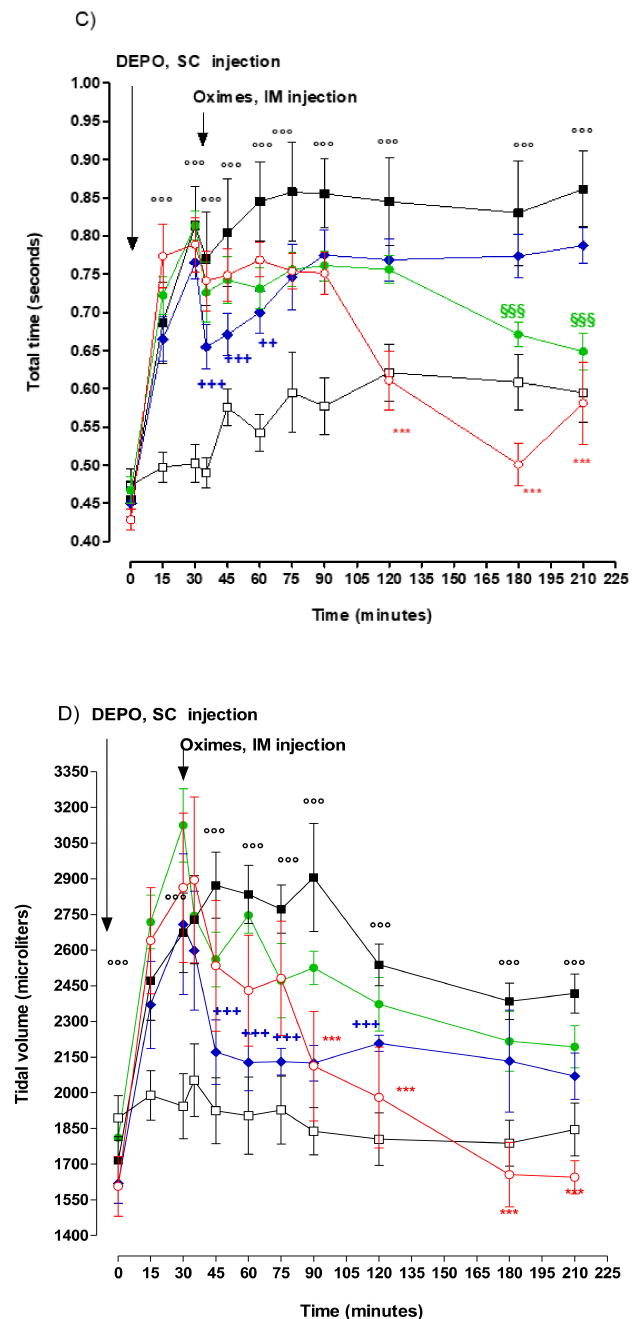
Figure 3. Time-course of frequency (f , Panel A ), expiratory time ( T E , Panel B ), total time ( T TOT, Panel C ), and tidal volume ( V T , Panel D ) in control group (open squares-black line), diethyl-paraoxon (DEPO) group (black squares-black line), diethyl-paraoxon + pralidoxime (DEPO + PRX group (blue diamond-blue line), DEPO + KO-27 group (green diamond-green line), and DEPO + BI-6 group (red open circle-red line). Each group contained eight rats. Data are represented by mean ± SEM. DEPO vs Control: ◦◦◦ p < 0.001; DEPO + PRX vs. DEPO: ++ p < 0.01, +++ p < 0.001; DEPO + KO-27 vs. DEPO: $$ p < 0.01, $$$ p < 0.001; DEPO + BI-6 vs. DEPO: ** p < 0.01, *** p <